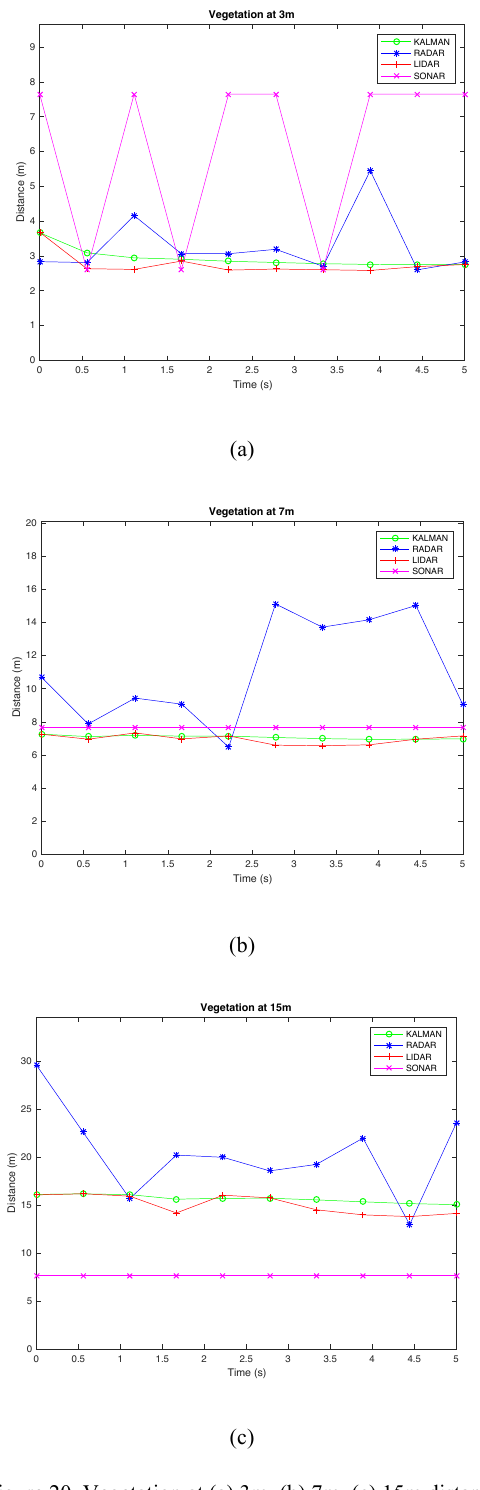
Figure 20. Vegetation at (a) 3m, (b) 7m, (c) 15m